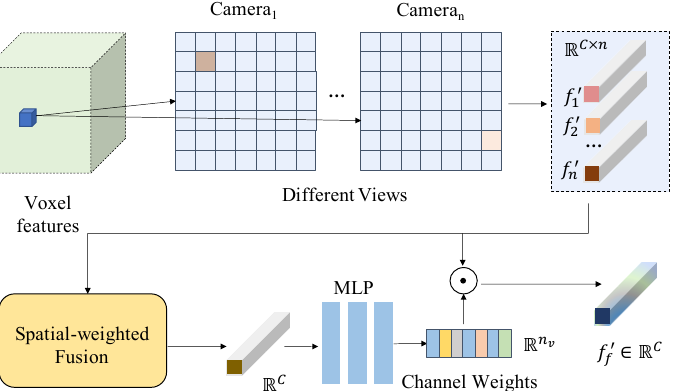
Figure 4. Illustration of the proposed view fusion method. Corresponding multi-view 2D features of each voxel are fused by (1) spatial reweighting and (2) channel